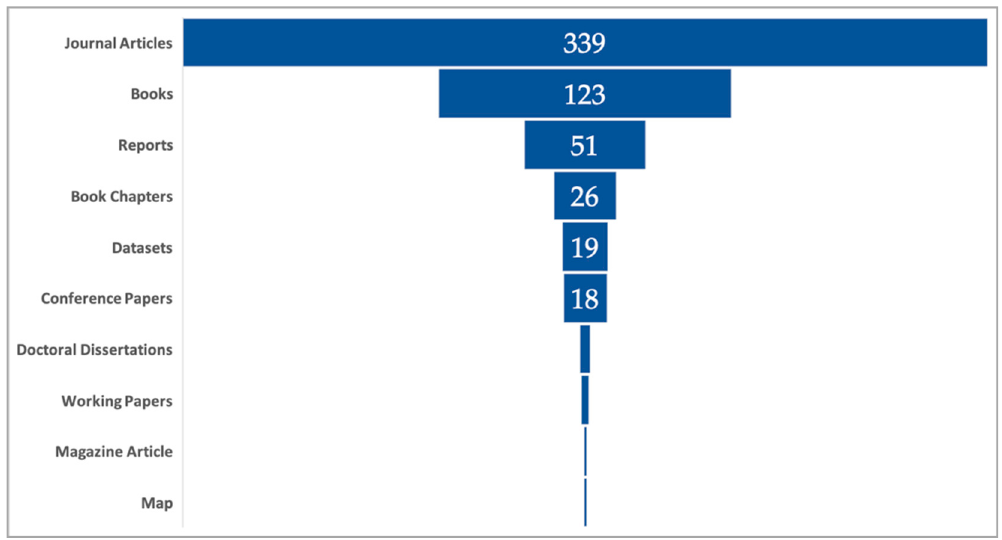
Figure 1. Publication frequencies by type of publication outlet. Source : Author compilation.